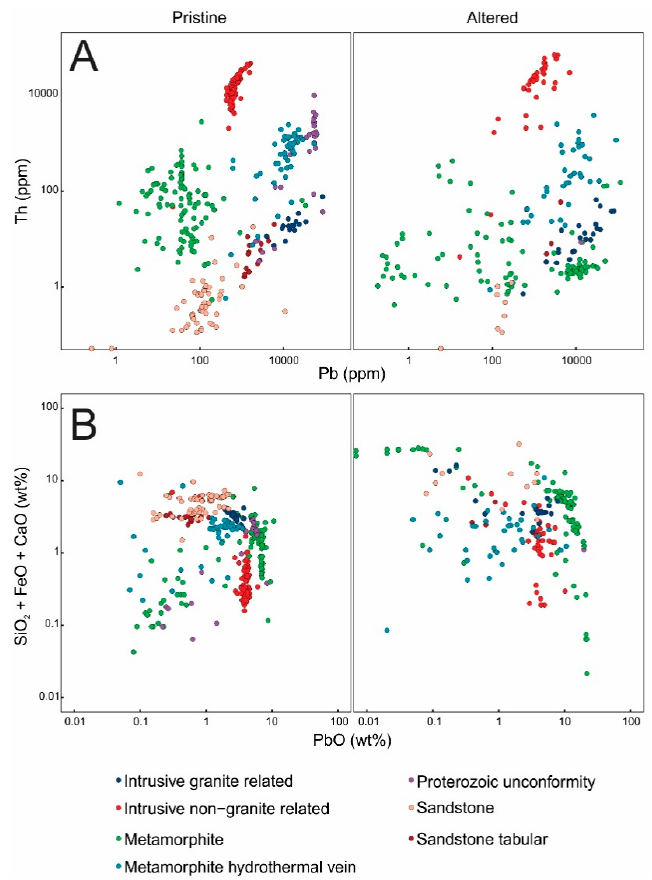
Figure 2. ( A ) Log–log Th (ppm) versus Pb (ppm) for both pristine (UO 2 > 80 wt. %) and altered (UO 2 70–80 wt. %) uraninite. ( B ) Log–log cation wt. % (SiO 2 + FeO + CaO) and PbO (wt. %) for pristine and altered areas of the uraninite samples.